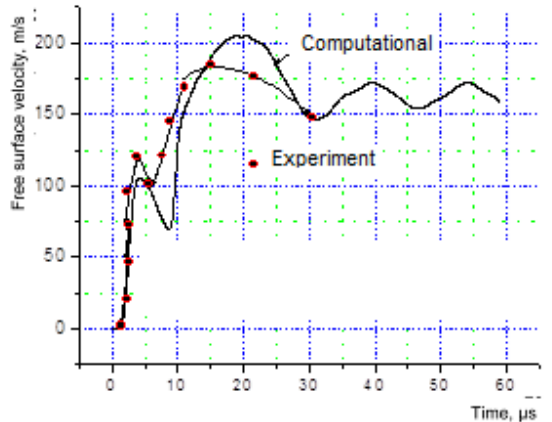
Fig. 3. Free surface velocity profile (experiment Vs